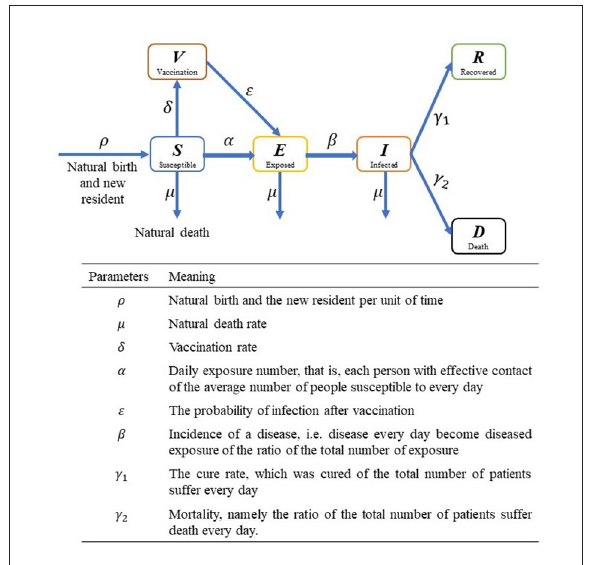
FIGURE3 Illustration of compartmental model. S, E, I, R, D and V represent susceptible, exposed, infected, recovered, death and vaccination people,